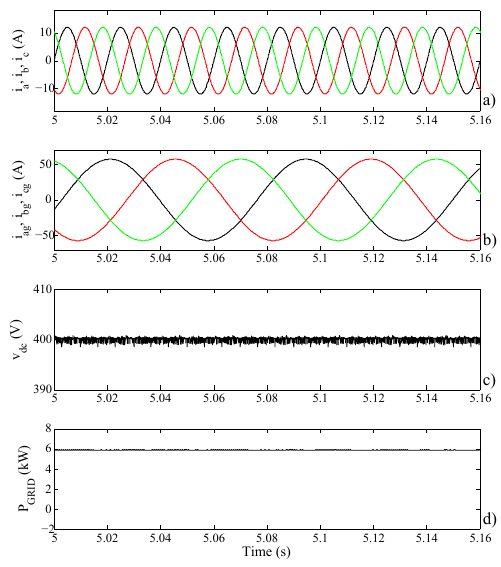
Figure 7. ( a ) Grid currents; ( b ) Generator currents; ( c ) DC voltage; ( d ) Active power injected into the grid.